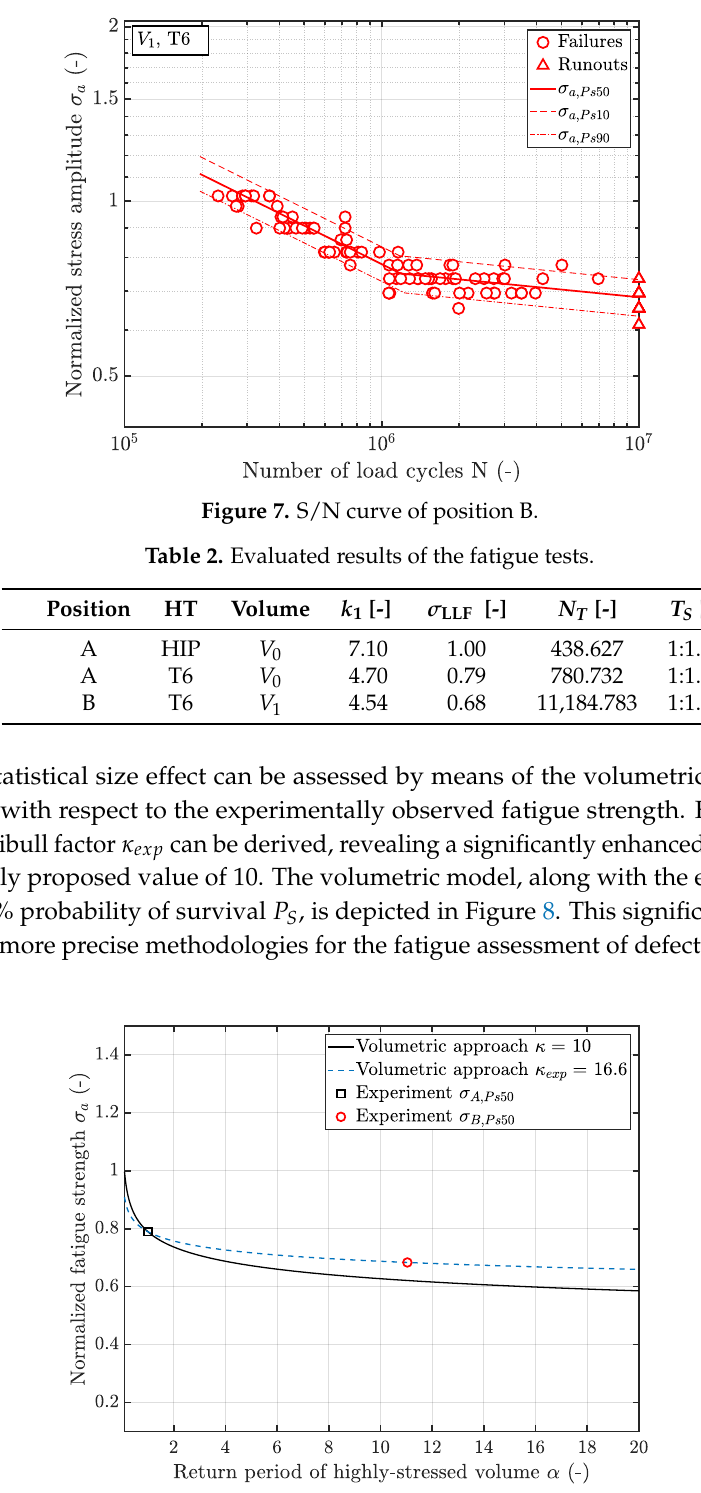
Figure 8. Volumetric model with the theoretical and experimentally deduced Weibull factor κ